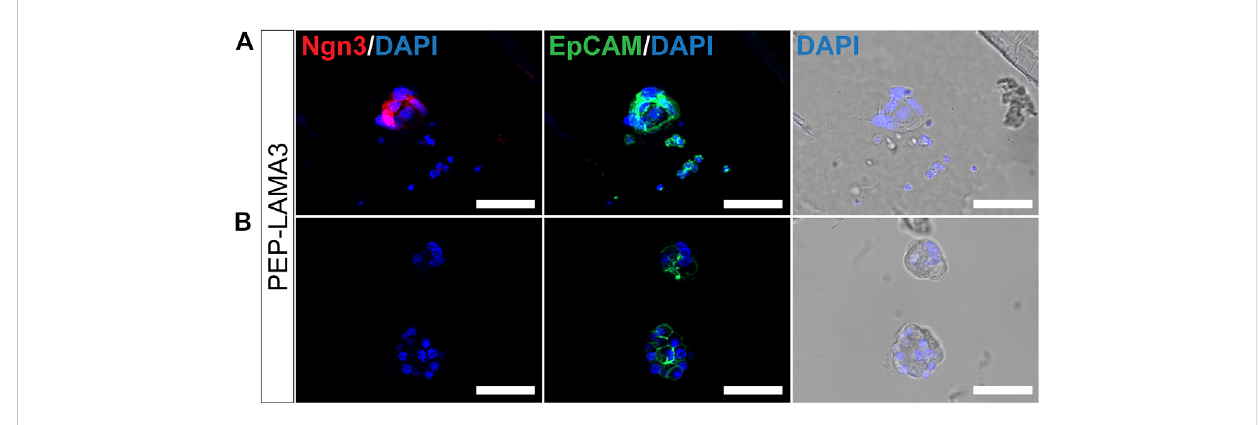
FIGURE 5 Whole-mount immuno fl uorescence staining reveals that some cells grown in PEP-LAMA3 express Ngn3, an endocrine progenitor marker. (A) Photomicrographs of cells in a colony grown from PEP-LAMA3 expressing the endocrine progenitor marker Ngn3 (B) Photomicrographs of other cells grown from PEP-LAMA3 that were handled as in (A) but did not express Ngn3. The positive control marker, EpCAM, was used to identify pancreatic epithelial cells. DAPI nuclear staining was overlaid with the bright fi eld images of the colonies. Scale bars = 50 µm.